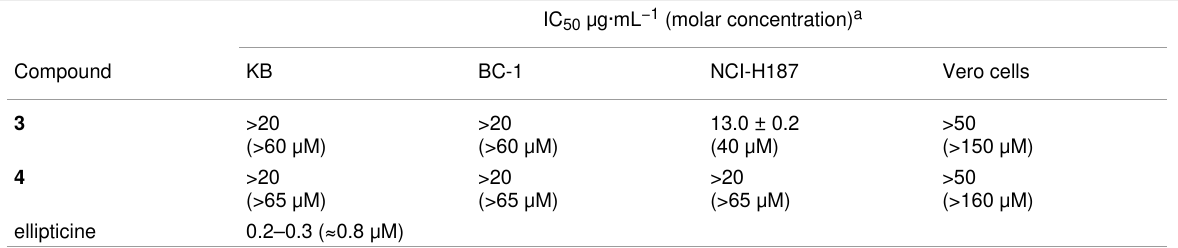
Table 1: Results from cytotoxicity assays of combretastatin D-3 ( 3 ) and D-4 ( 4 ) against cancer cell lines [18].